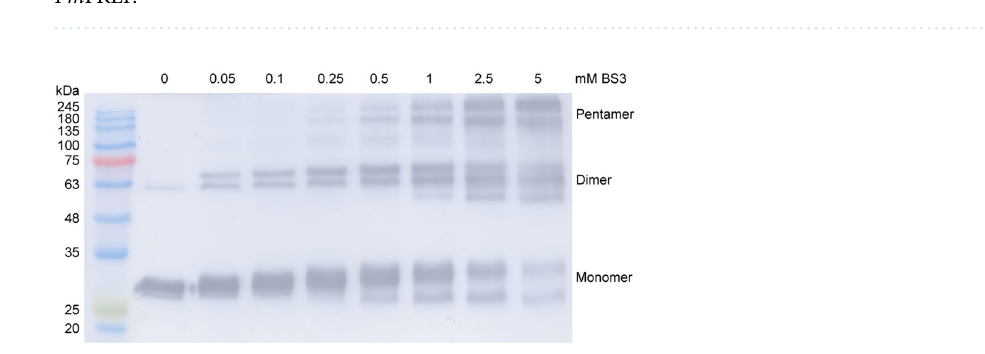
Figure 3. TEM micrograph of ( A ) His 6 Pm FREP, ( B ) His6 Pm FREP CRD, and ( C ) 2D class averages of His 6 Pm FREP.